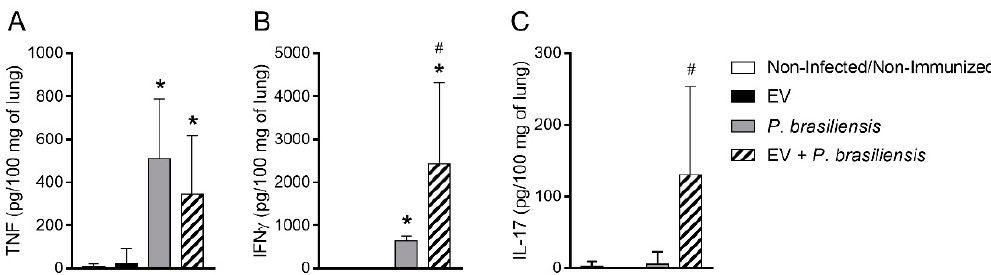
Figure 6. Immunization with EVs from P. brasiliensis increases cytokine levels 72 h post-infection. TNF ( A ). IFN- γ ( B ) and IL-17 ( C ). * p ≤ 0.05 compared to non-infected/non-immunized and EV groups. # p ≤ 0.05 compared to non-infected/non- immunized, EV and P. brasiliensis groups. Non-infected/non-immunized (control). Immunization for 42 days with two doses of 1000 ng of EV protein with adjuvant (boost dose, without adjuvant, given 14 days after the first dose). Data represents the mean of two independent experiments. n = 8 animals per group.